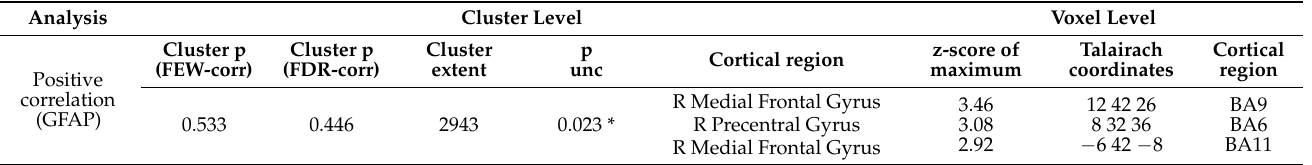
In the Cluster level section (left), the number of voxels, the uncorrected and corrected p -value of significance and the cortical region where the voxel is found are reported for each significant cluster. In the Voxel level section (right), all coordinates of the correlation sites (with z-score of the maximum correlation point) and the corresponding subcortical region are reported for each significant cluster. L: left; R: right; FEW: Familywise error; FDR: False discovery rate; BA: Broadman Area; p unc: uncorrected p, * = p <